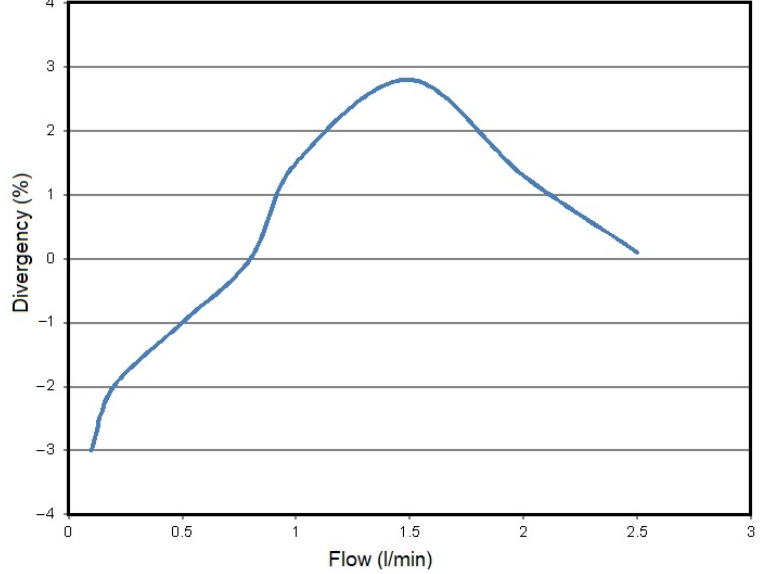
Figure 8. Correlation diagram of divergency vs. liquid volume flow rate.